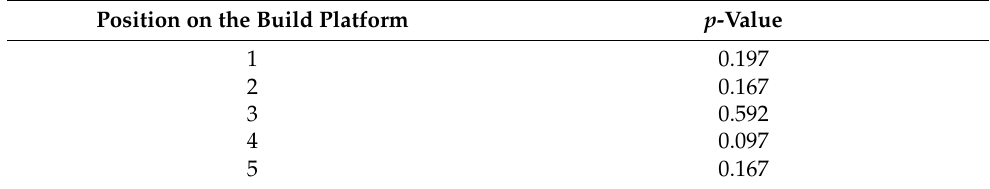
Table 4. Significance of Levene’s test when comparing different positions on the build platform at the X-axis according to the p -value.